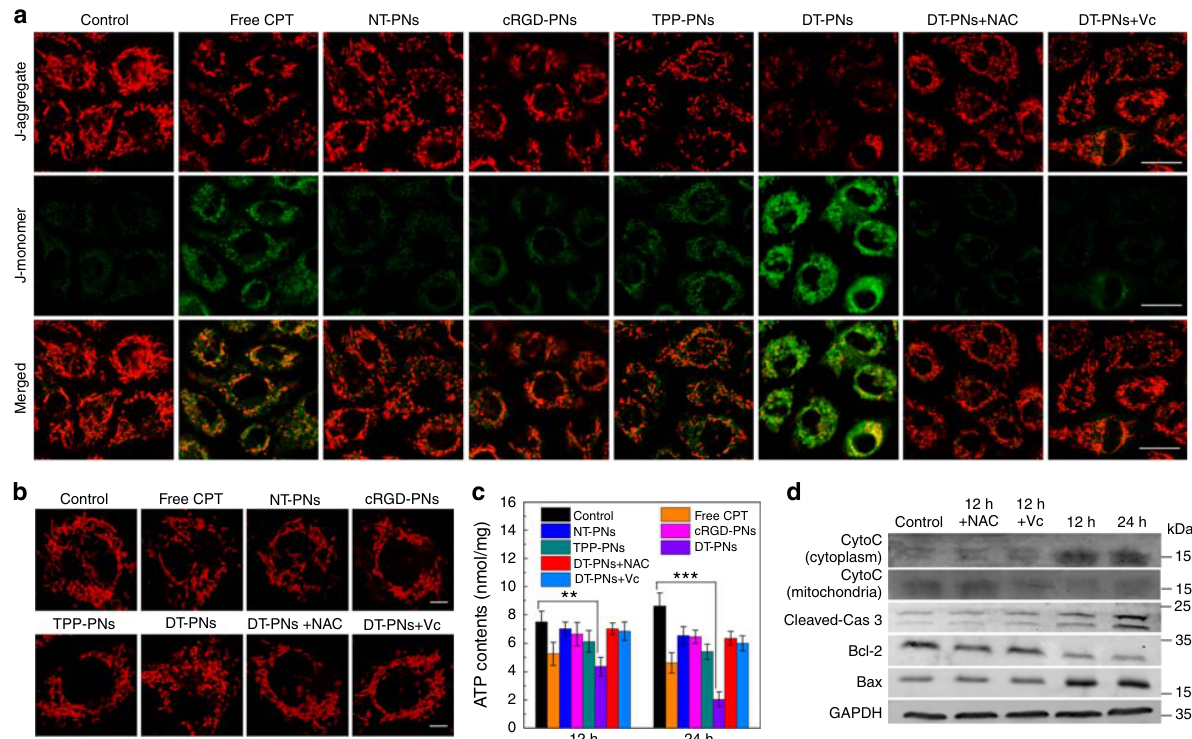
Fig. 6 Mitochondrial damage-induced apoptosis of cancer cells by DT-PNs. a CLSM images of JC-1 stained cells after different treatments, the fl uorescence transition from red to green indicated signi fi cant mitochondrial damage (scale bar, 20 μ m). b CLSM imaging of mitochondrial morphology in 4T1 cells after incubation for 24 h with DT-PNs, the cells were stained with MitoTracker Red (scale bar, 5 μ m). c 4T1 cells were treated with DT-PNs for 12 h and 24 h for the cellular ATP measurement. The mean value was calculated by the t test (mean ± s.e.m. n = 3). ** p < 0.01, *** p < 0.001, compared with the indicated group. d Western blotting analysis for the expression of Cyto C, cleaved-caspase 3, Bcl-2, and Bax proteins after treating with DT-PNs for 12 and 24 h